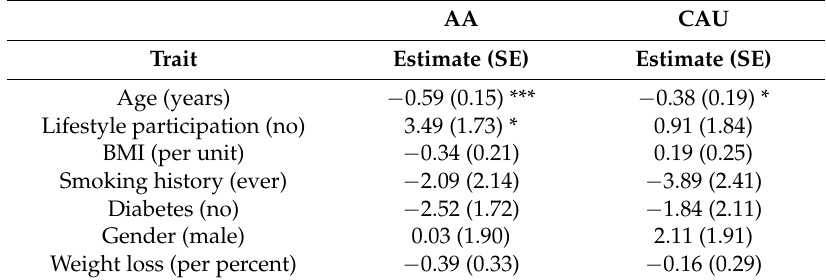
Table 3. Multivariable regression analysis of ∆ SBP and traits of interest. The indicated traits were analyzed for association with ∆ SBP in a multivariable linear model within each ancestral